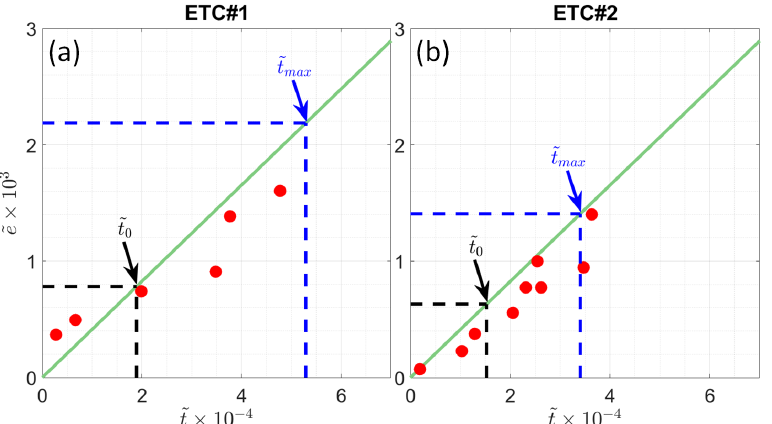
Figure 11. Dimensionless energy, ˜ e , versus dimensionless time, ˜ t , for ETC#1 ( a ) and ETC#2 ( b ): red circles are observations, and green lines are duration laws (6). Dashed-black and dashed-blue lines indicate the dimensionless time interval t 0 and t max defined by (7) and (8), and corresponding dimensionless energy predicted by duration laws